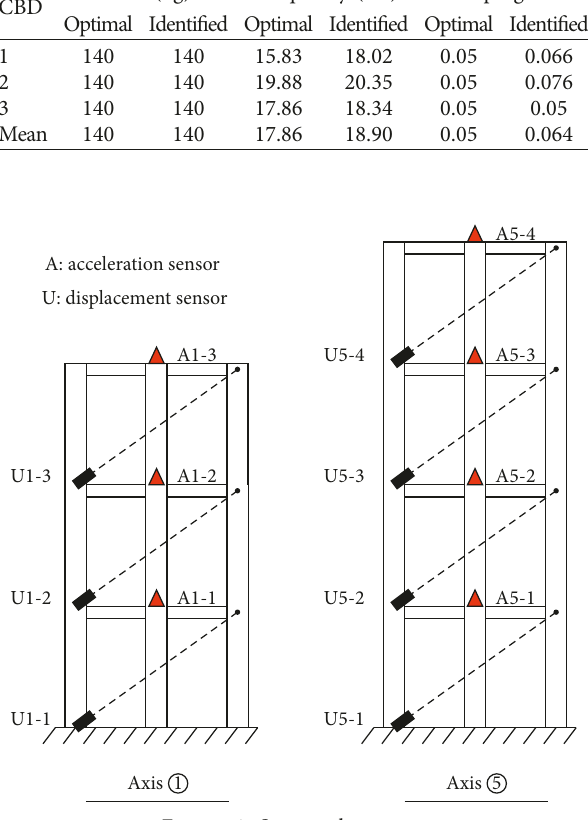
Figure 9: Sensor placement.